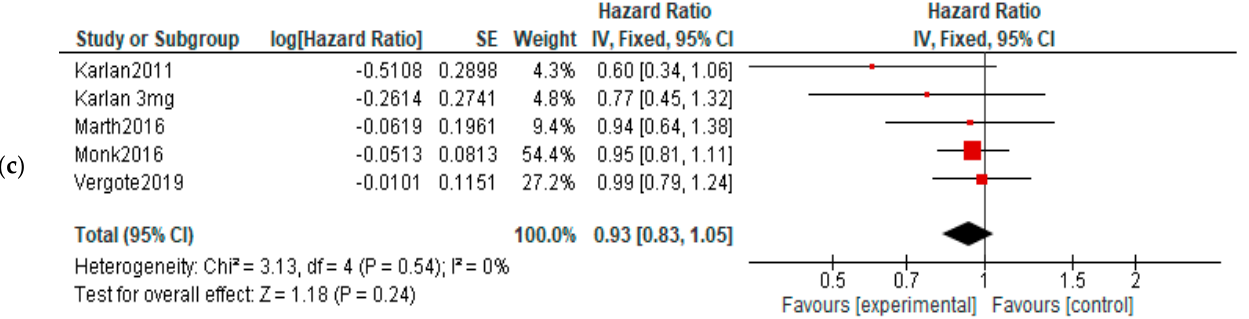
Figure 6. Action-mechanisms subgroup analysis of overall survival: ( a ) VEGF inhibitors, ( b ) VEGF-R inhibitors and ( c ) angiopoietin inhibitors. The black diamonds are visual representations of pooled effect and its confidence intervals and are non-significant if they overlap 1. Red squares represent each study effect size and study weight (size of square). The lines represent each study confidence interval. PLm—placebo maintenance; BEVm—bevacizumab maintenance [26–48,50,52].